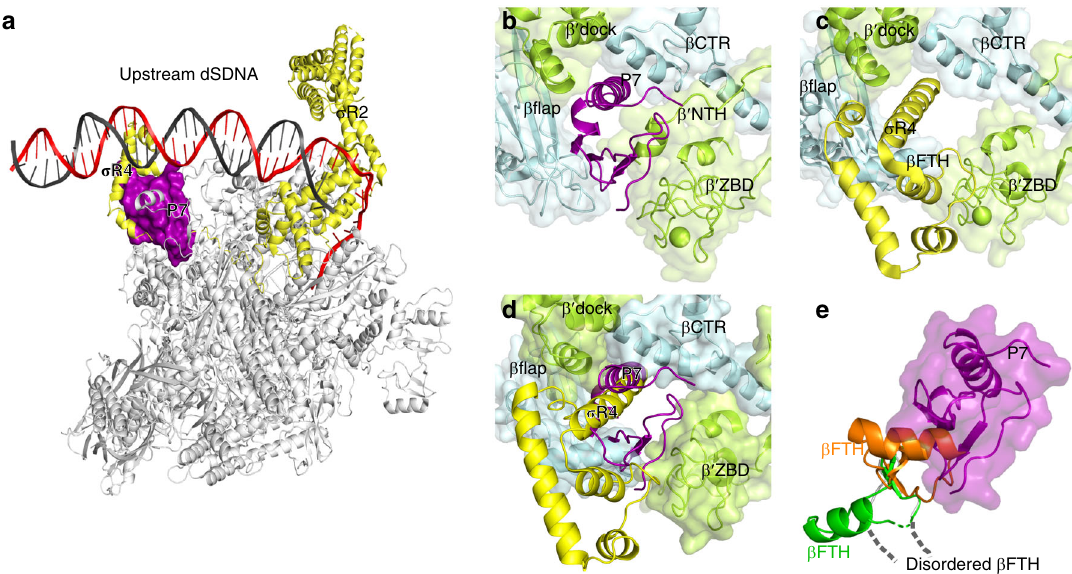
Fig. 6 P7 displaces σ R4. a The structural superimposition between E. coli RPo (PDB: 6CA0) and P7-TEC highlights the steric clash between P7 and σ R4. b P7 binds to the outer rim of and inserts into the RNA-exit channel in the P7-TEC structure. c σ R4 also binds to the outer rim of and inserts into the RNA- exit channel in the structure of E. coli RPo (PDB: 6CA0). d Both P7 and σ R4 interact with the same structural modules in RNAP and are incompatible with each other. e Structural superimposition suggests steric clash between the RNAP β FTH and P7. The β FTH adopts different conformations in structures of P7-TEC (gray; disordered), P7-NusA-TEC (green), and RPo (orange) Our cryo-EM structures and biochemical results provide the structural basis and molecular mechanisms for transcription inhibition and antitermination by the bacteriophage protein, P7. The binding site of P7 might serve as a new pocket for devel- opment of novel bacterial RNA polymerase inhibitors.